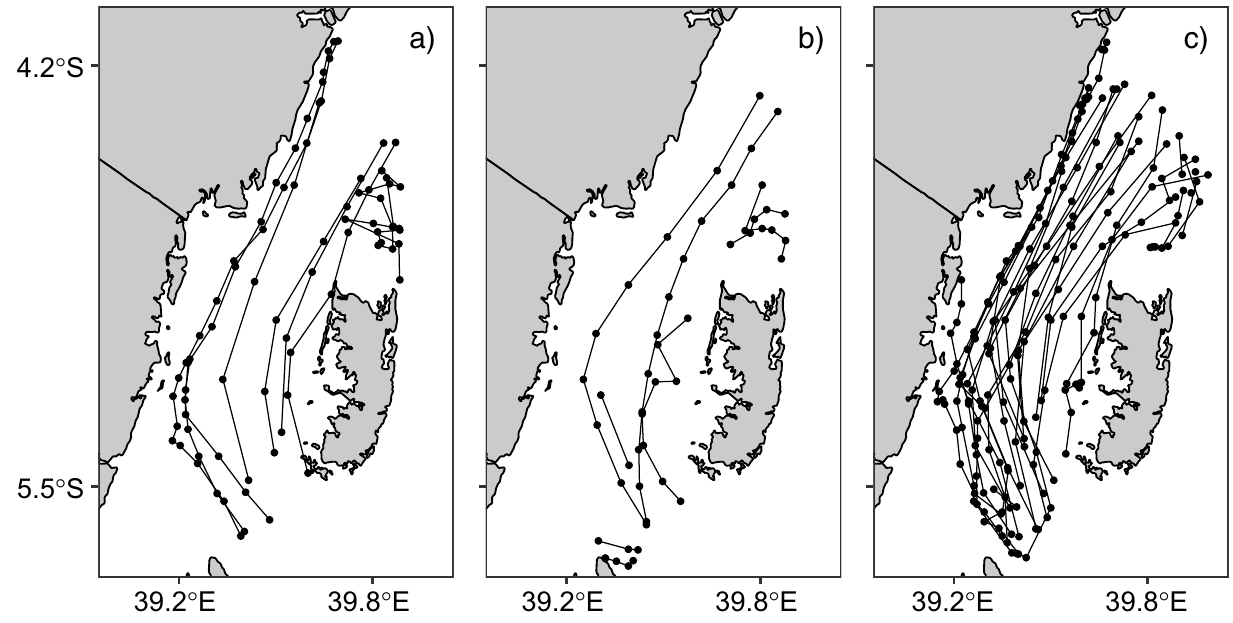
Fig 5. Drifters’ Trajectories in the Pemba Channel during a) IN, b) NE, and c) SE monsoon seasons.